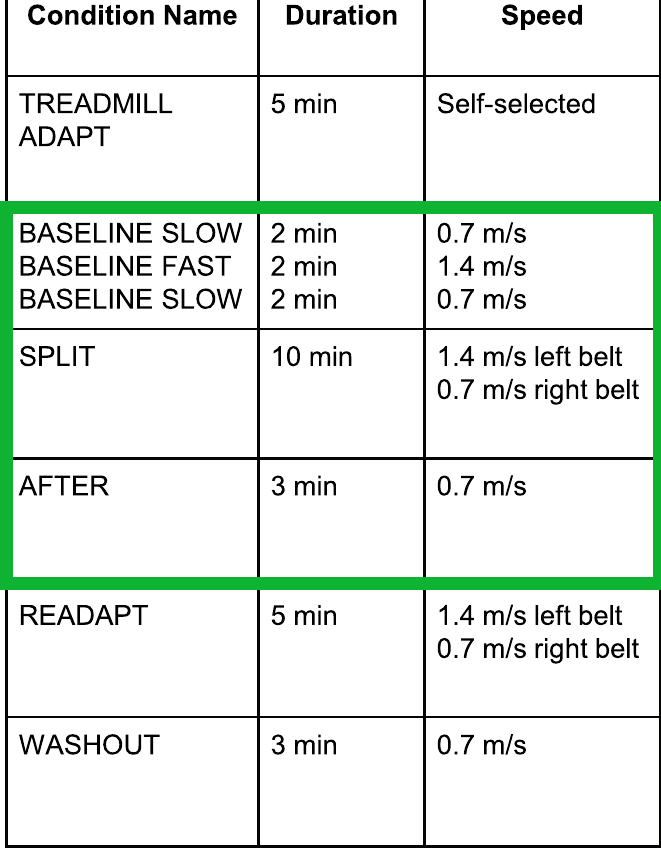
Table 1. Order of walking protocols for the split-belt adaptation paradigm. For this analysis, we only focus on the highlighted (green)